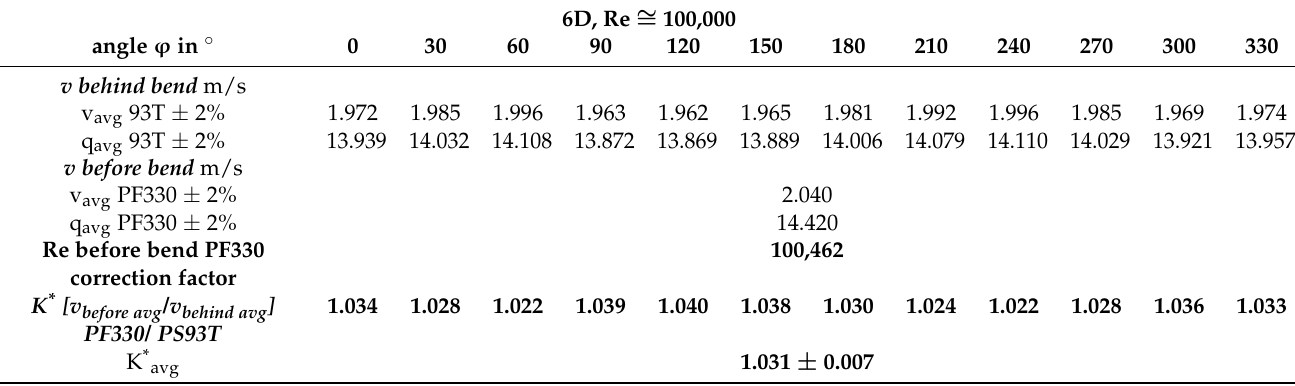
Table 6. Summary of the results of ultrasonic measurements for the 6D plane from the disturbing element as a function of the mounting angle of the ultrasonic flow meter sensors, Re ∼ = 100,000. 6D, Re ∼ =